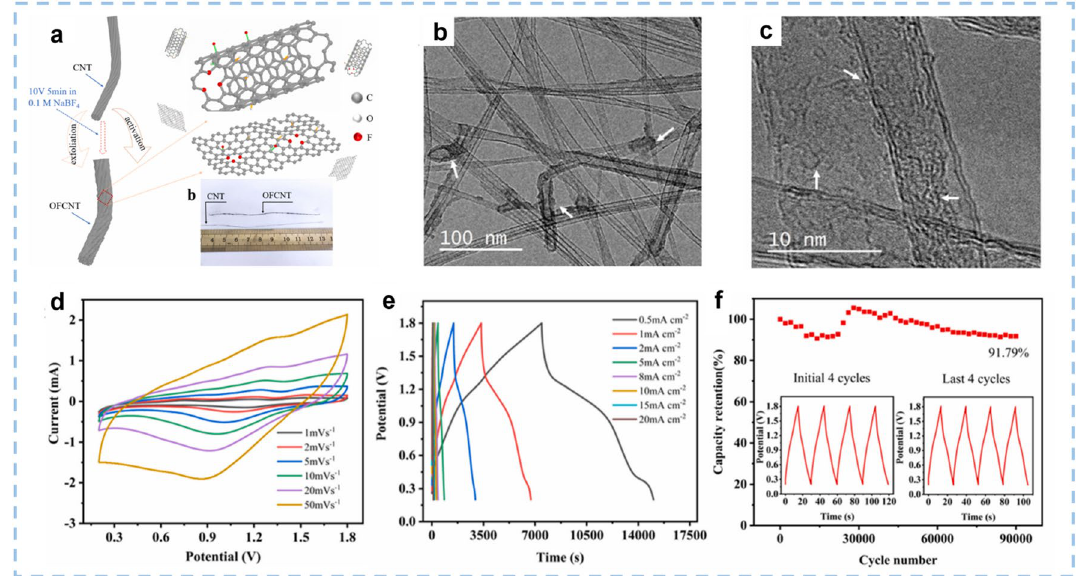
Fig. 6 The synthesis route, morphology, and structure of the OFCNT-5 sample and the electrochemical performance of Zn//OFCNT-5 device. a Diagram of the synthesis route of OFCNT sample. b TEM image and c the relevant HRTEM image of the OFCNT-5 fiber bundles sample. d CV curves of Zn//OFCNT-5 device at various scan rates of 1–50 mV s −1 . e GCD curves of Zn//OFCNT-5 device under various areal current densi- ties of 0.5–20 mA cm −2 . f Long-cycling stability of Zn//OFCNT-5 device over 90,000 cycles under the current density of 1 mA cm −2 , the inset images depict the initial 4 cycles and the last 4 cycles of GCD curves. Reproduced with permission [117]. Copyright 2022,